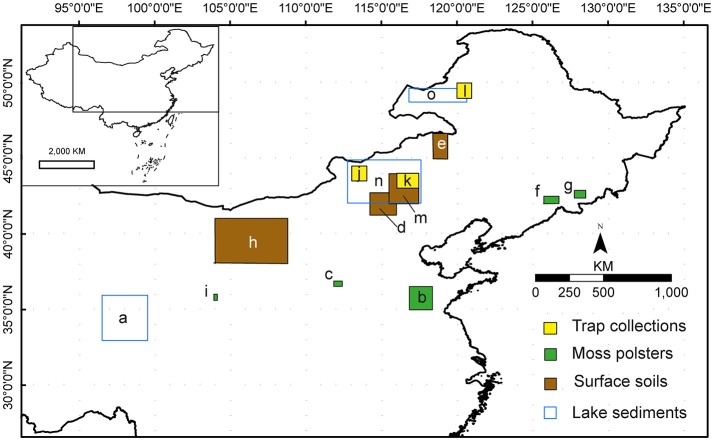
Location of the areas selected for the 11 studies on relative pollen productivities (RPP) reviewed in this paper. a. (Wang and Herzschuh, 2011), Tibetan Plateau. b. (Li et al., 2017), Shandong. c. (Zhang et al., 2017), Taiyue Mountains. d. (Ge et al., 2015), central Inner Mongolia. e. Li et al., manuscript in preparation, northeastern Inner Mongolia. f. (Li et al., 2015), Changbai Mountains. g. (Zhang et al., 2017), Changbai Mountains. h. (Li et al., 2011), Alashan Plateau, western Inner Mongolia. i. (Wu et al., 2013), Xinglong Mountains. J. (He et al., 2016). Hulunbeier, northeastern Inner Mongolia. k. (He et al., 2016) Xilinhaote, central Inner Mongolia; l. (He et al., 2016). Sunitezuoqi, central Inner Mongolia. m. (Xu et al., 2014), central Inner Mongolia. n. (Han et al., 2017) Xilinguole, central Inner Mongolia. o. (Han et al., 2017). Hulunbeier, northeastern Inner Mongolia.